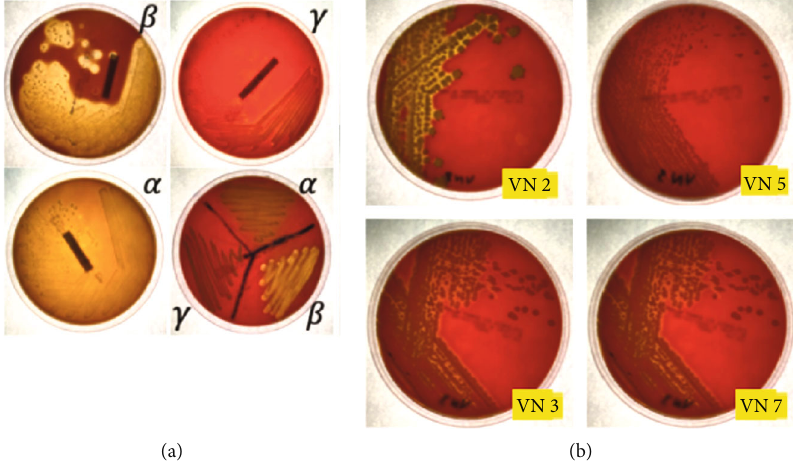
Figure 10: The control of three types of hemolysis (a). Hemolysis assays of VN2, VN3, VN5, and VN7, respectively